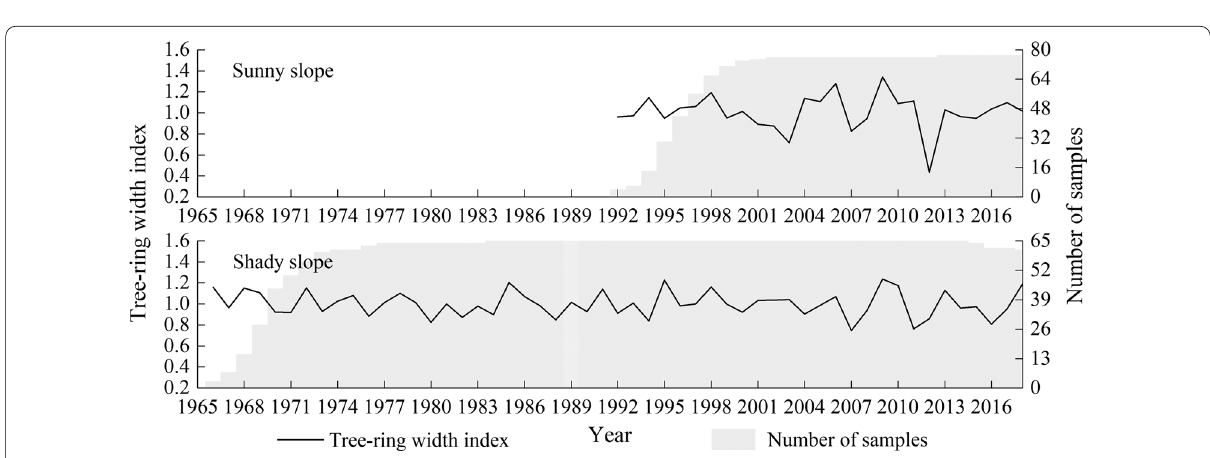
Fig. 3 Tree-ring width residual chronologies (solid black line) and the sample depths (grey-shaded area) at different